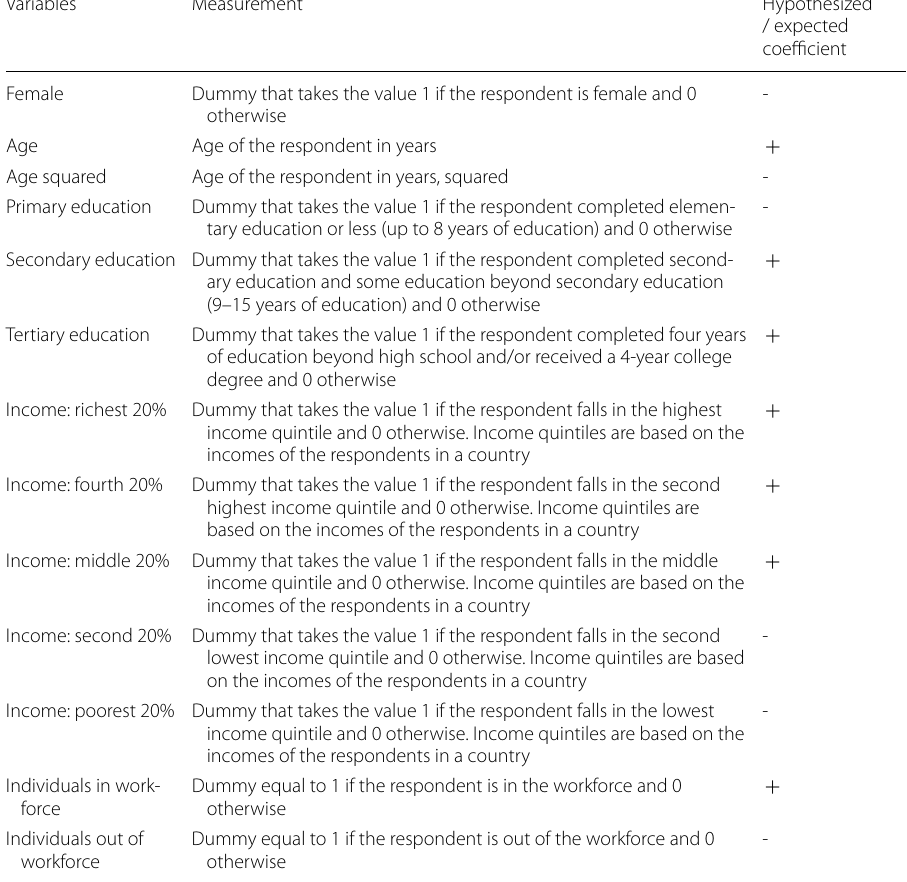
Table 5 Measurement and expected sign of explanatory variables on financial inclusion